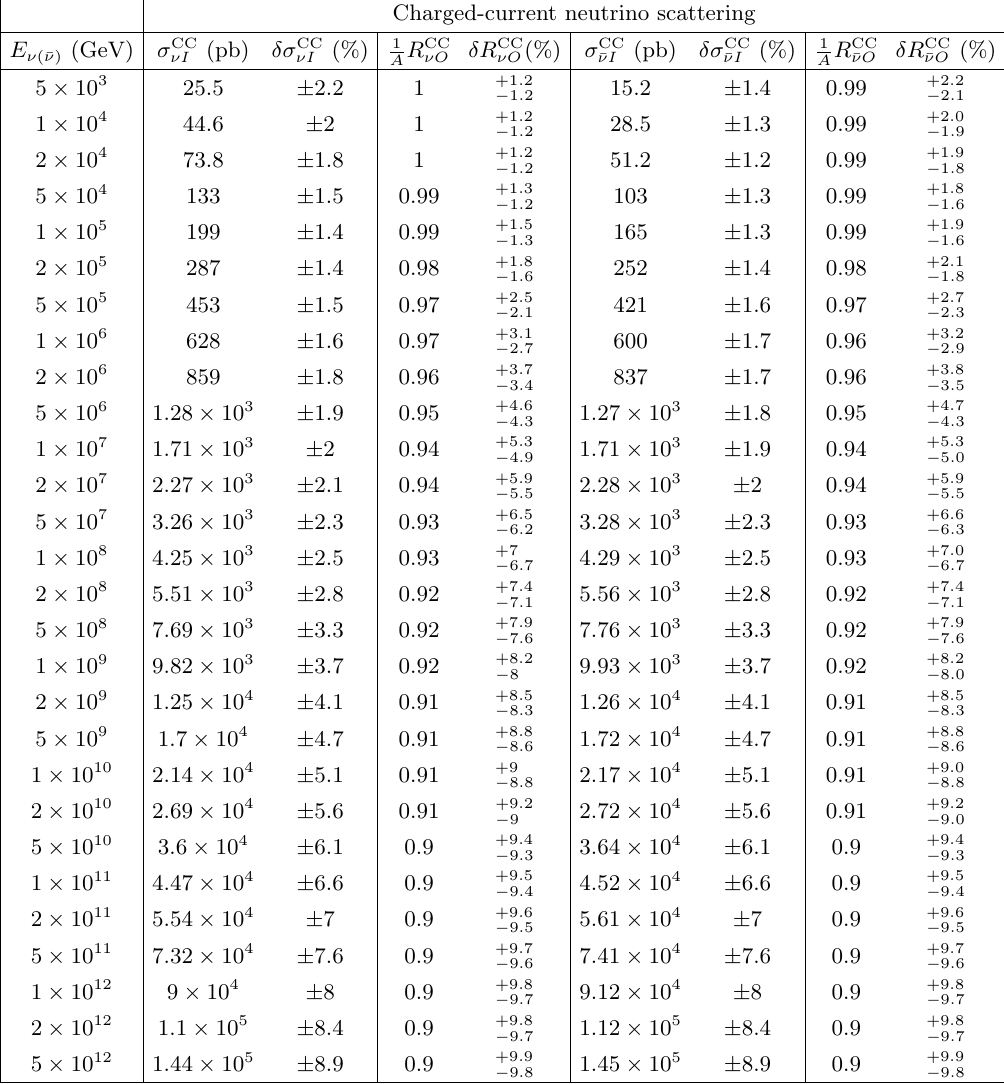
Table 2 . The BGR18 charged-current neutrino total cross-sections (cid:27) CC as a function of the (cid:23) ( (cid:23) ) I energy E (cid:23) . We show the results for the scattering of a (anti)neutrino o(cid:11) a free isoscalar target together with the percentage proton PDF uncertainties, (cid:14)(cid:27) CC . We also list the values of the (cid:23) ((cid:22) (cid:23) ) I nuclear correction factor R =A , eq. (2.10), computed with the EPPS16 set and the percentage (cid:23) ((cid:22) (cid:23) ) O nPDF uncertainty, (cid:14)R CC . (cid:22) (cid:23) ((cid:22) (cid:23) ) O